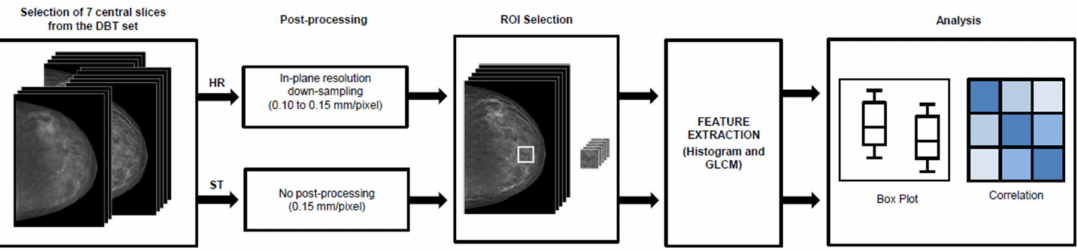
Figure 1. Workflow followed for texture analysis. DBT, digital breast tomosynthesis; ROI, region of interest; GLCM, gray level co-occurrence